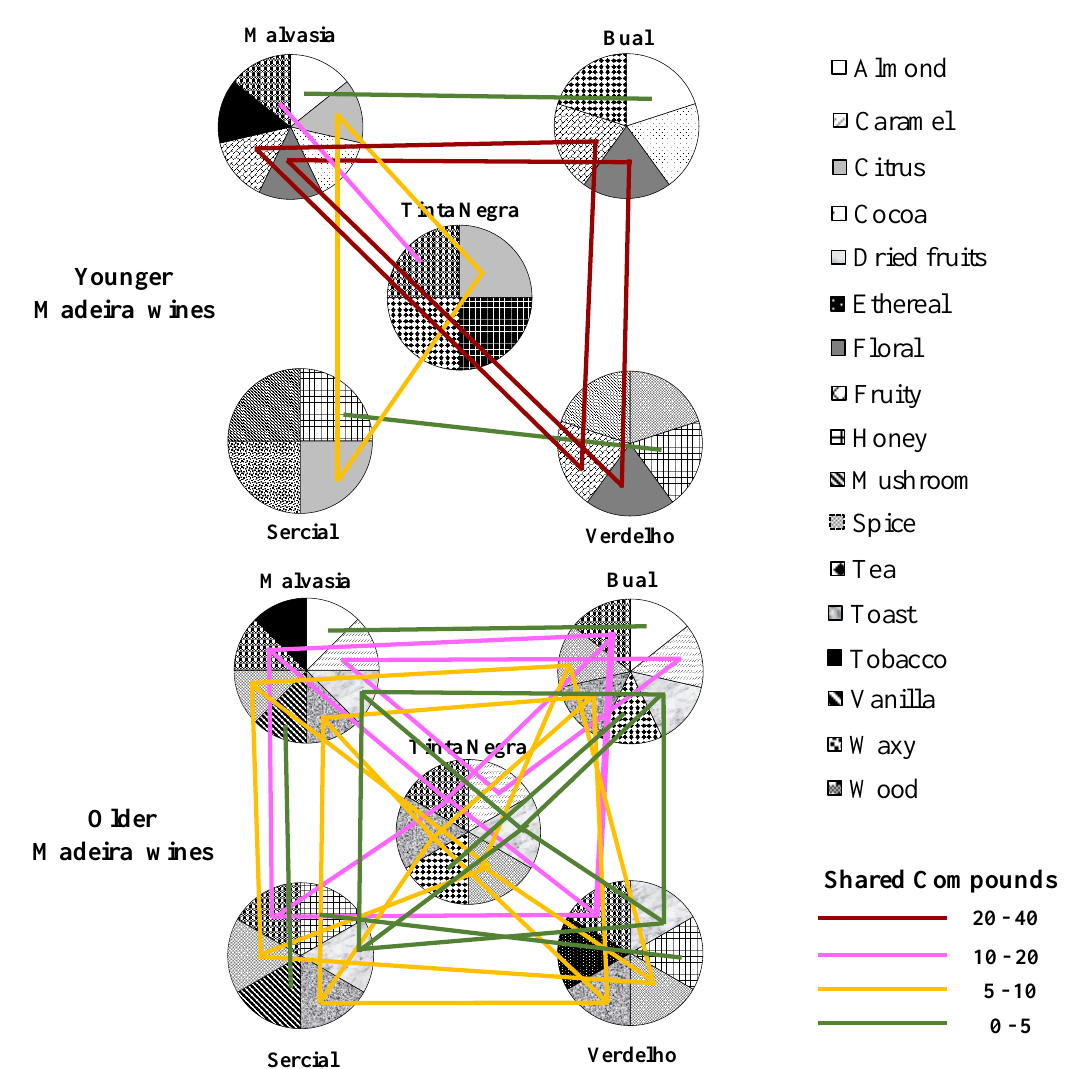
Figure 2. Aroma system. Each color represents an aroma note. The color line corresponds to the number of shared VOCs.